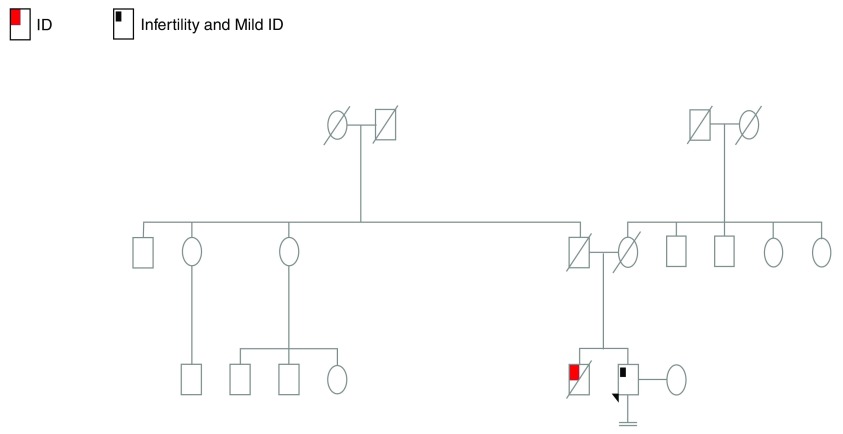
Patient’s pedigree.